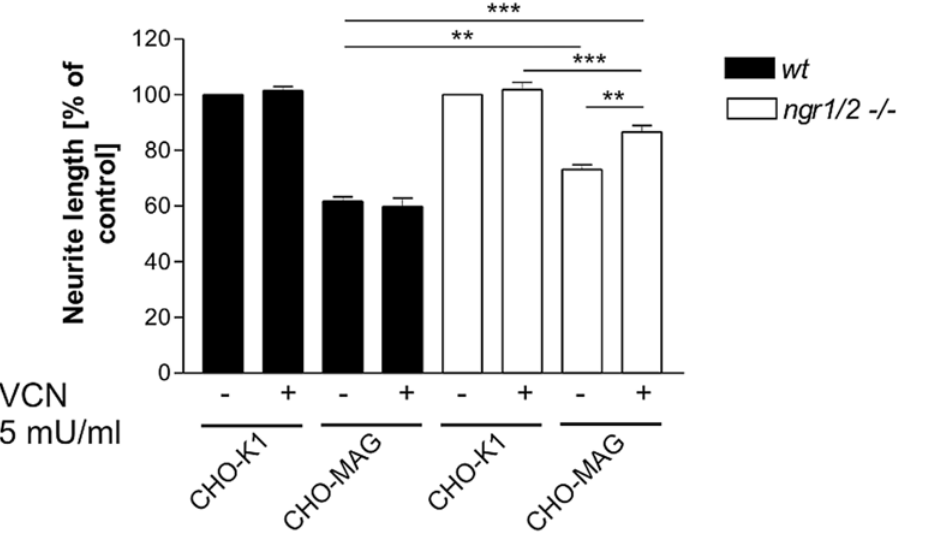
Figure 3. MAG-mediated inhibition of neurite outgrowth of ngr1/2 2 / 2 sensory neurons with and without VCN treatment. Sensory neurons derived from wildtype or ngr1/2 2 / 2 mice were seeded onto parental and MAG expressing CHO-K1 cells. Treatment with 5 mU/ml Vibrio cholerae neuraminidase (VCN) was started one hour after plating. Cells were fixed approx. 20 hours after plating. Graph shows % neurite length 6 SEM of wildtype and ngr1/ngr2 double knock-out neurons on the different substrates. At least three separate experiments were examined for each experimental condition, with 100–150 neurons measured for each substrate. *** represents P # 0.001, ** represents P # 0.01 one-way analysis of variance with post-hoc Tukey test.